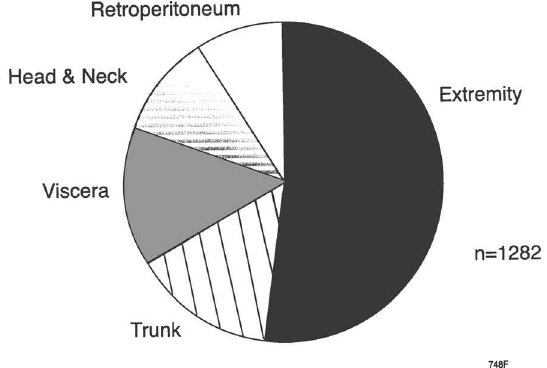
Fig. 1. The frequency of sites of presentation for soft tissue sar- coma. Data are from a prospective database of all soft tissue